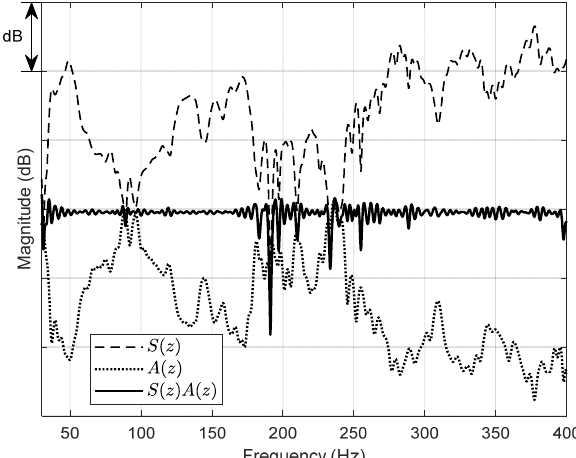
Figure 11. Comparison of the magnitude responses of S ( z ) , A ( z ) , and S ( z ) A ( z ) indicated by dashed,